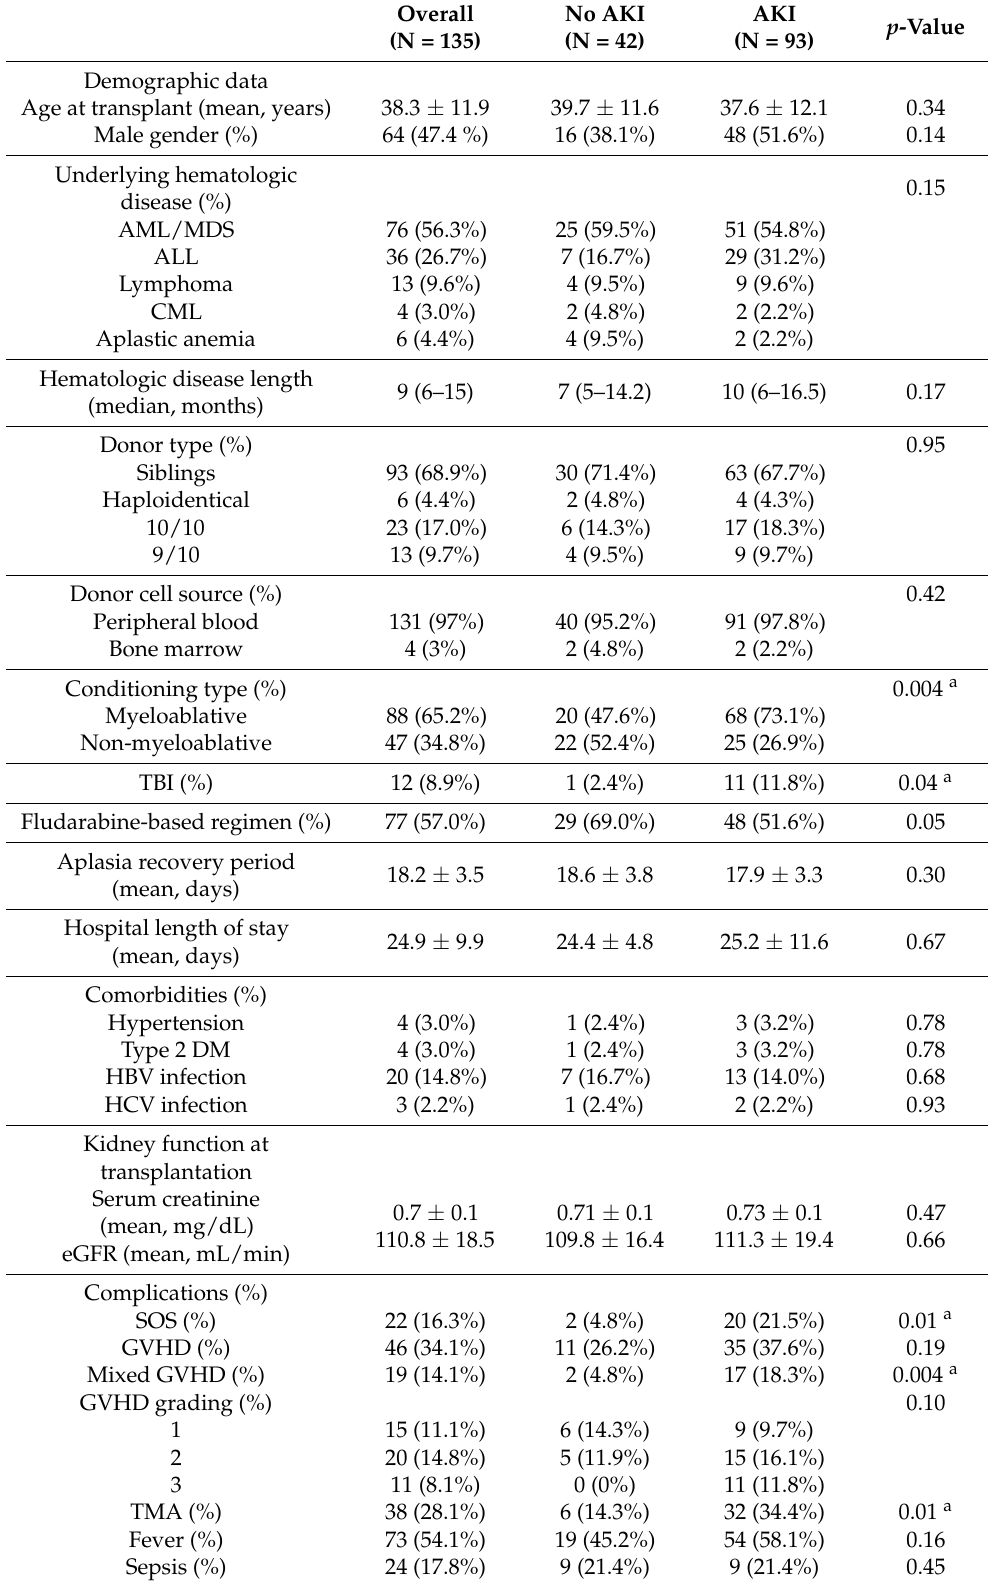
Table 1. Clinical, laboratory, transplant characteristics, and complications of the study